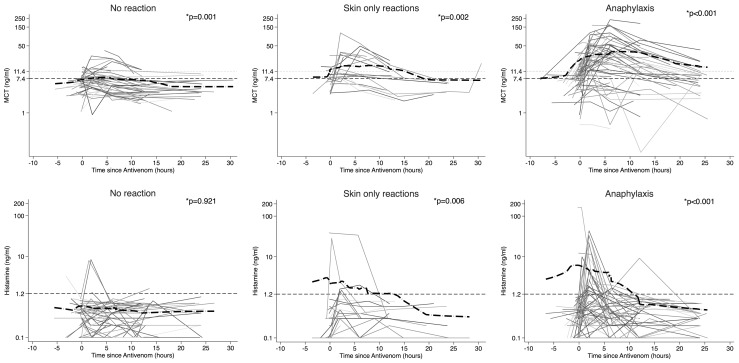
Changes in MCT and histamine concentrations during treatment with antivenom.Lowess curve (thick dash-dot line). Upper limit (99th centile healthy control values from our laboratory) (thin dashed line). Normal limit defined by assay (MCT only) (thin dotted line). * p-value for difference between pre-antivenom concentration and peak concentration during the first four hours post-antivenom (Wilcoxon Signed Rank Test).